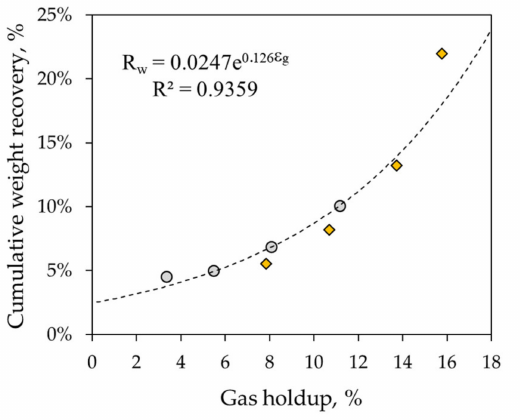
Figure 15. Cumulative weight recovery as a function of gas holdup after 12 min of